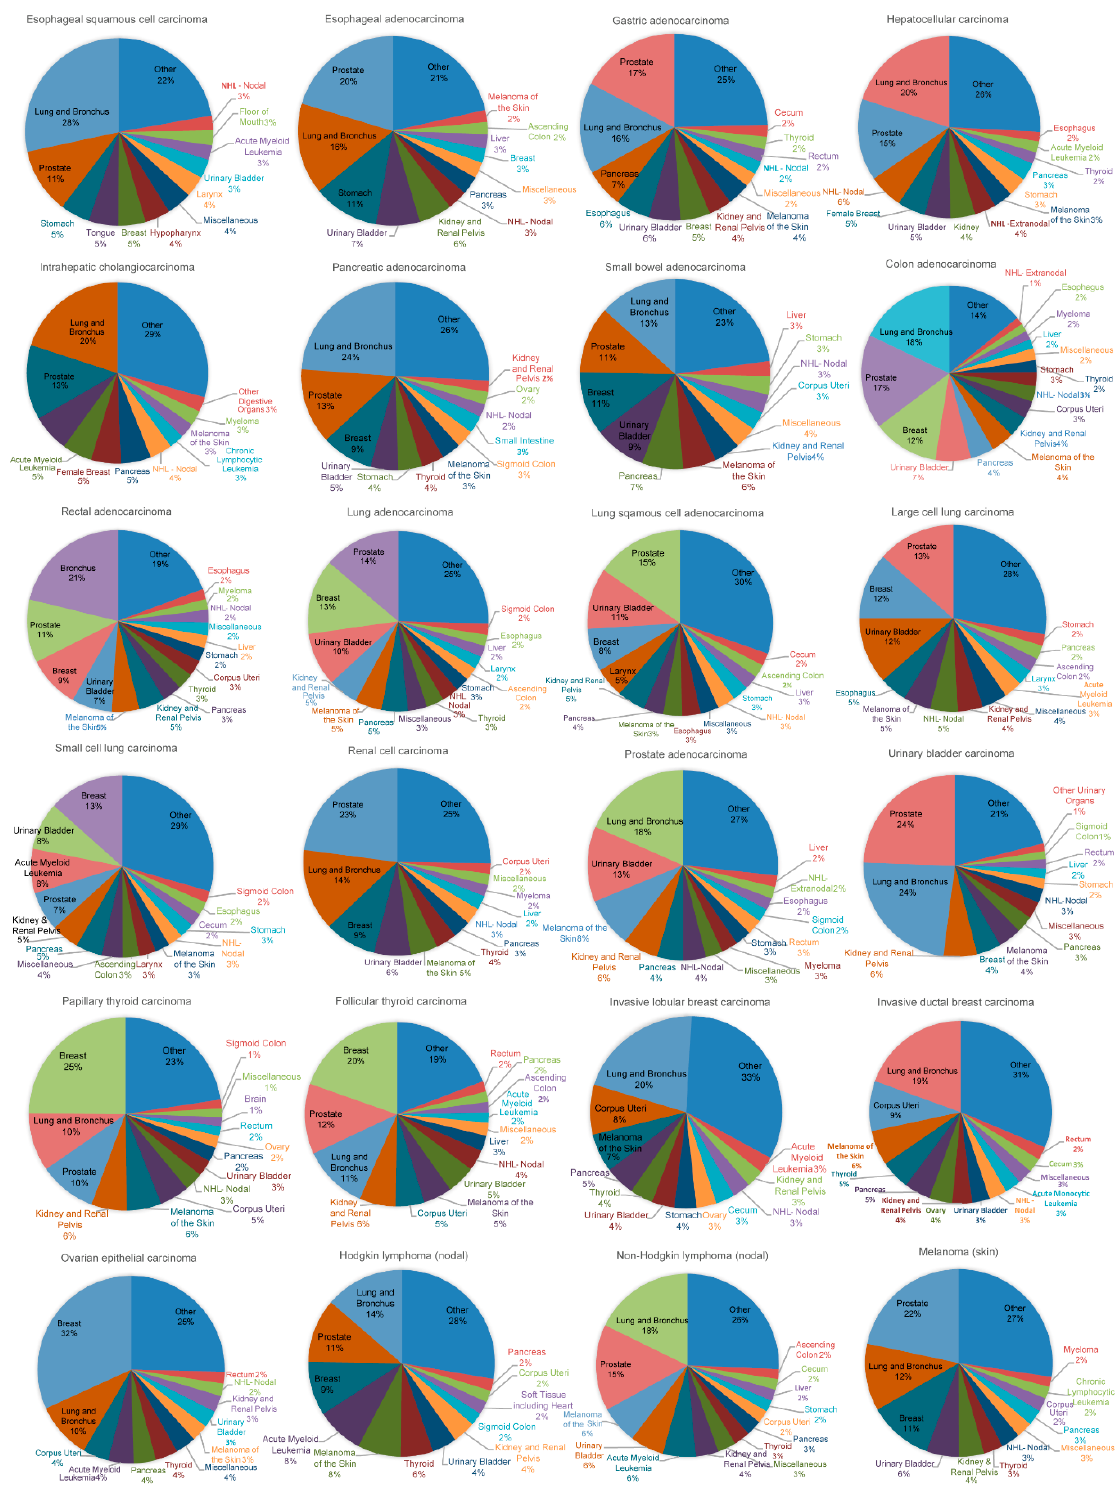
Figure 1. The proportion of the sites of the second primary malignancies of the 24 types of primary cancers.